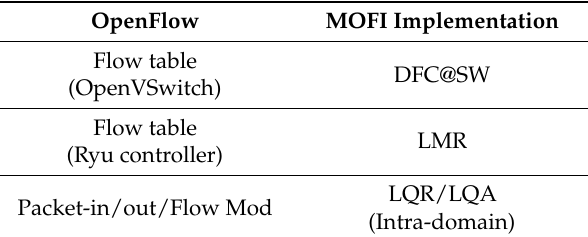
Table 4. Entity mapping between OpenFlow and the MOFI